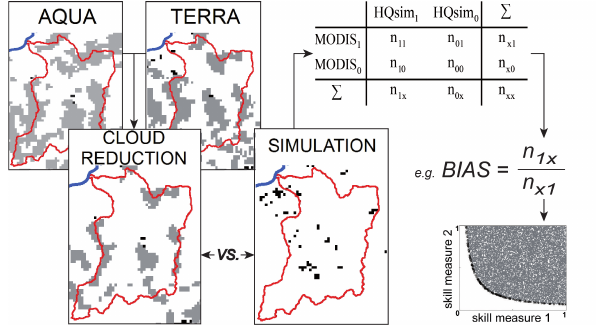
Fig. 2. Procedure of the comparison of simulations versus MODIS snow maps (map colours: grey: cloud, white: snow, black: no